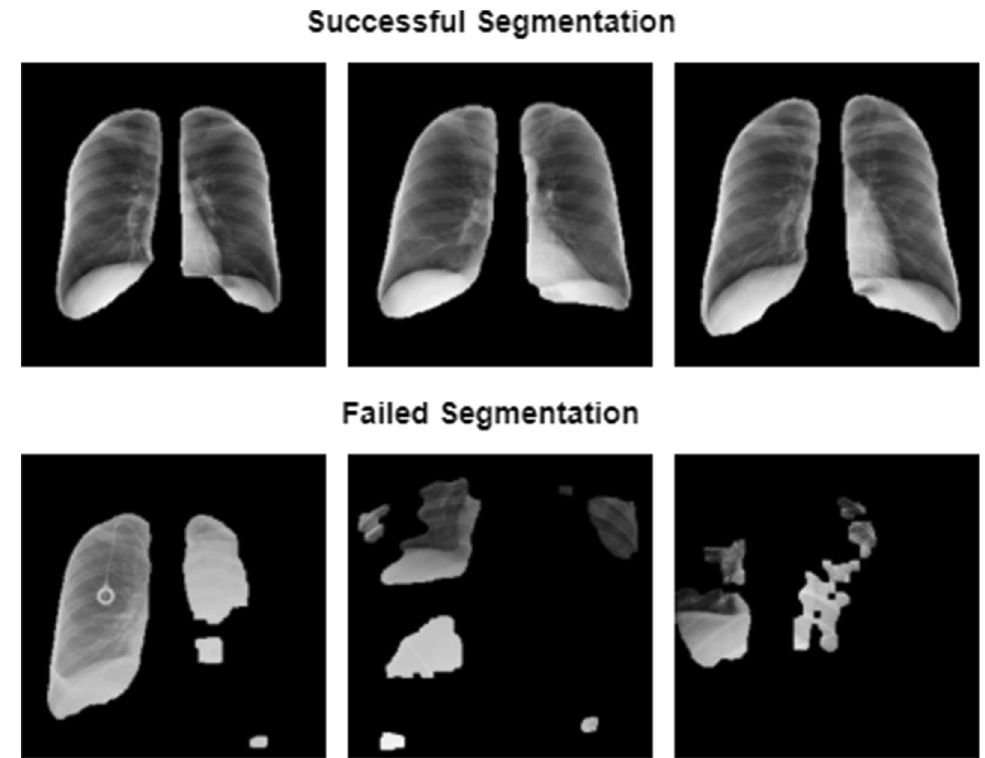
Figure 2. Output samples of our segmentation model on COVIDx images.